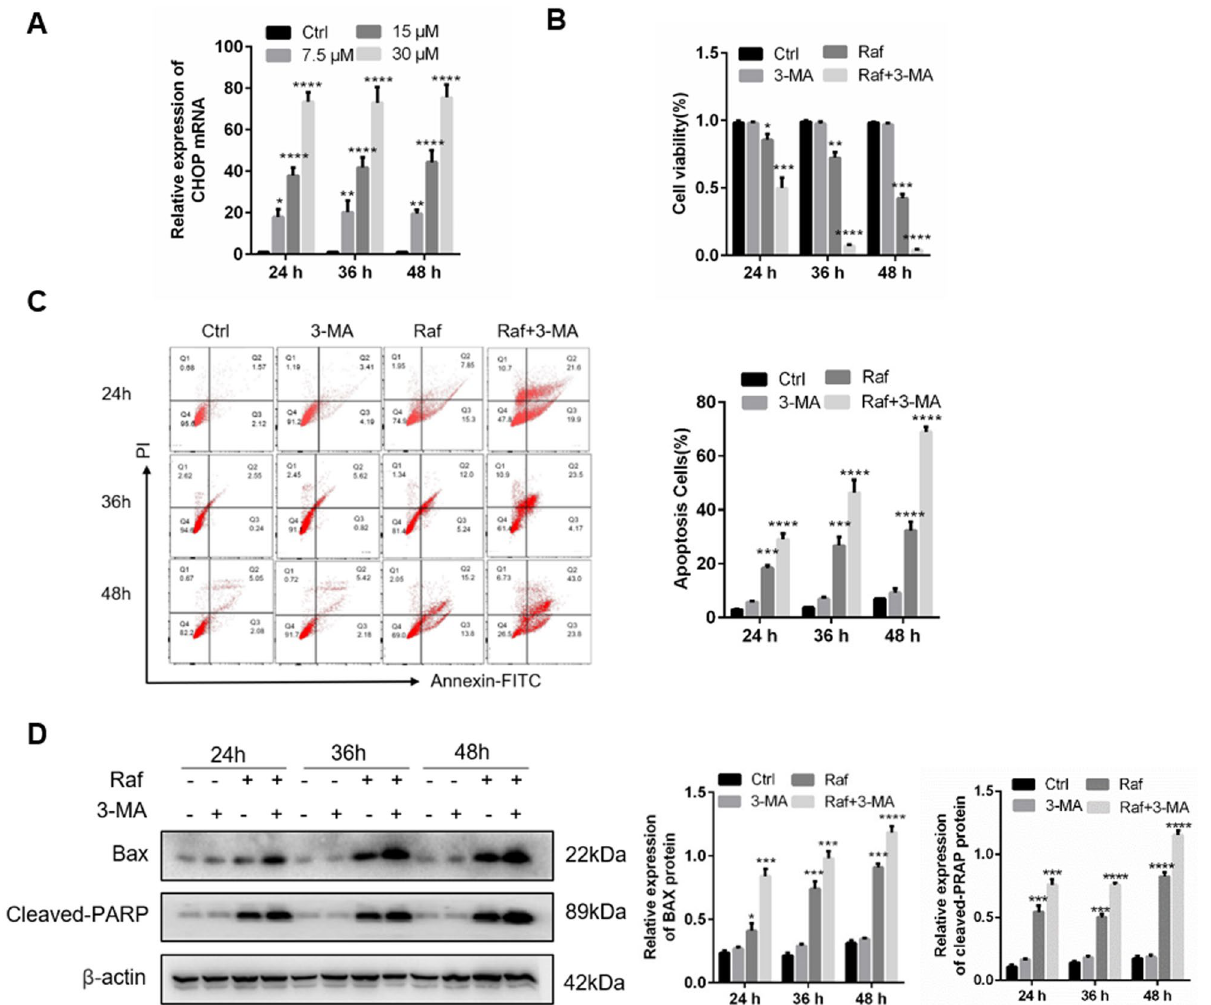
Figure 6. Autophagy induced by rafoxanide is involved in alleviation of rafoxanide-induced apoptosis. ( A ) A549 cells were treated with rafoxanide, and qRT-PCR was performed to detect mRNA expression of CHOP . ( B–D ) A549 cells treated with 30 μM rafoxanide for 24, 36, 48 h. 3-MA (5 mM) was added 2 h prior to rafoxanide. Cell viability was determined by the CCK8 assay. Apoptosis was analyzed by flow cytometry. Western blotting was performed to evaluate the protein expression levels of cleaved PARP and Bax. Data are expressed as mean ± SD of three experiments. * P < 0.05, ** P < 0.01, *** P < 0.001, **** P <